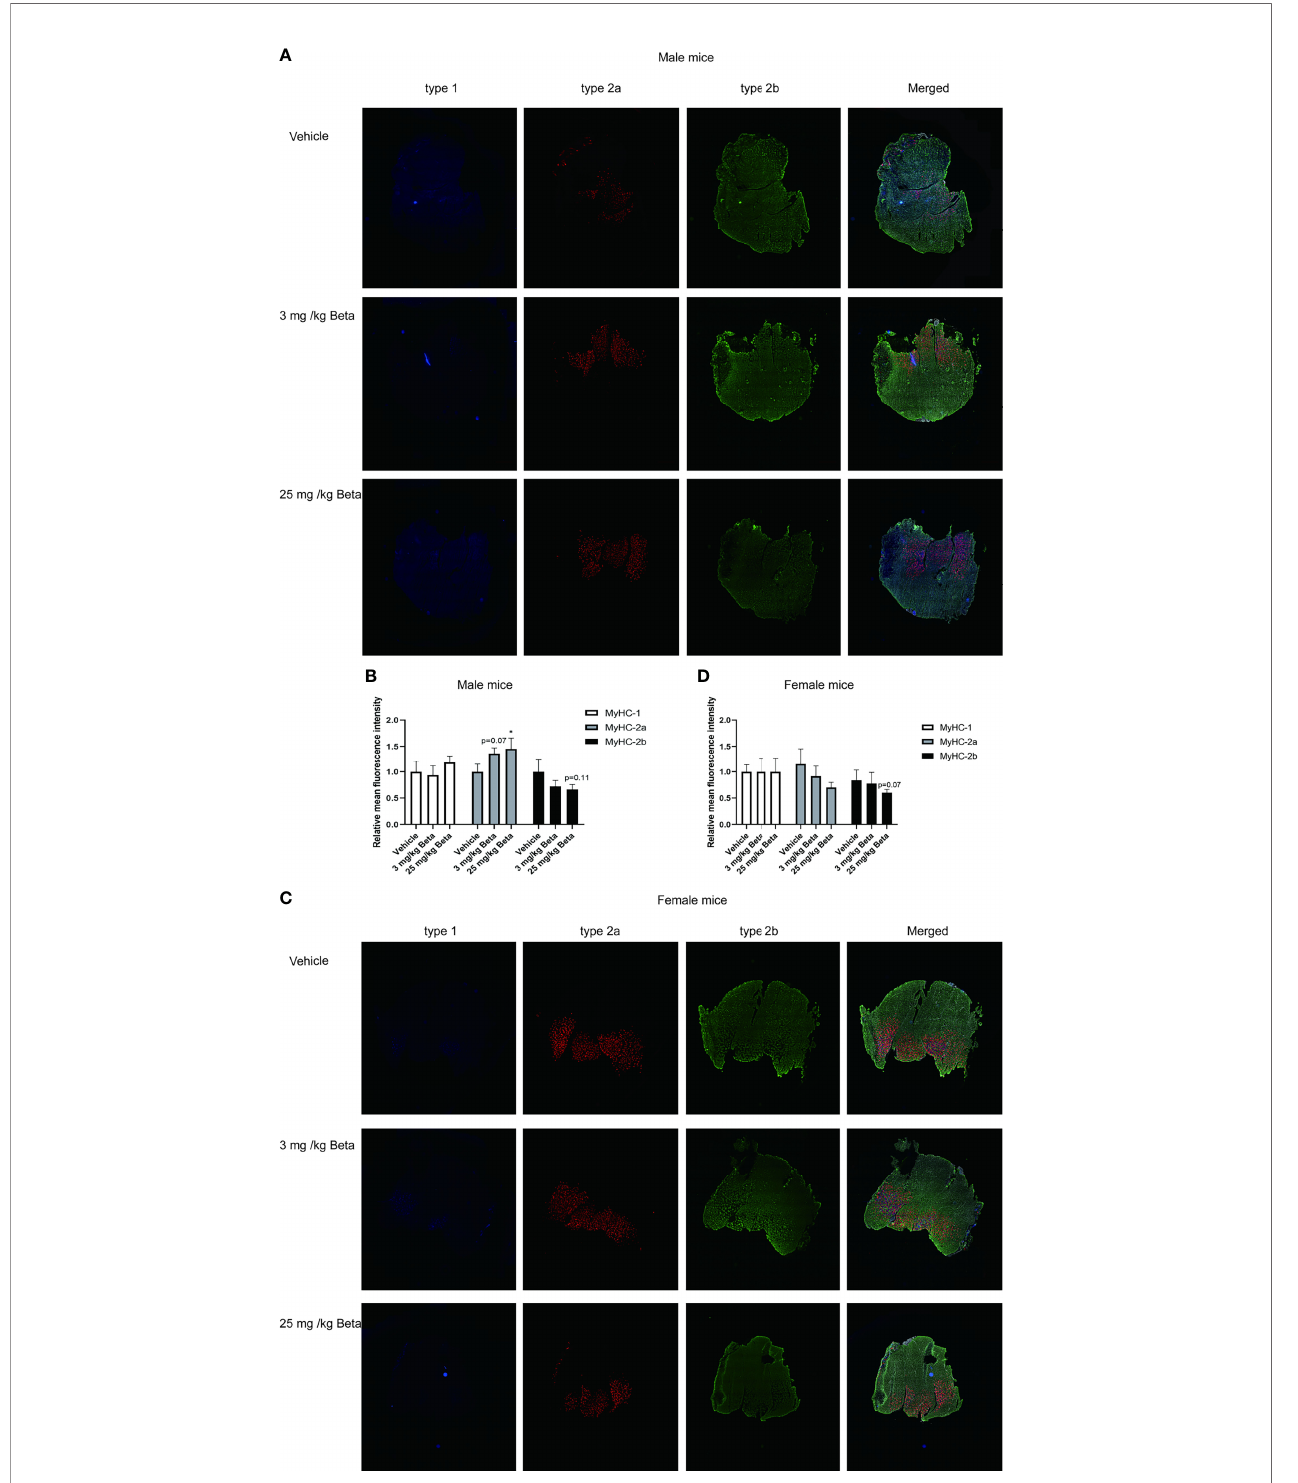
FIGURE 6 | Daily betamethasone treatment increases abundance of type 2A myo fi bers in male mice. Histological analysis of gastrocnemius muscle for type 1, type 2A and type 2B myo fi bers. (A) Representative images of myo fi ber staining in gastrocnemius muscle of male mice and (B) Relative mean fl uorescence intensity for individual myo fi ber isoforms. N=3 mice/group. (C) Representative images of myo fi ber staining in gastrocnemius muscle of female mice and (D) Relative mean fl uorescence intensity for individual myo fi ber isoforms. N=3 mice/group. Type-1=Blue; Type-2a=Red; Type-2b=Green. *p<0.05 vs. Vehicle.